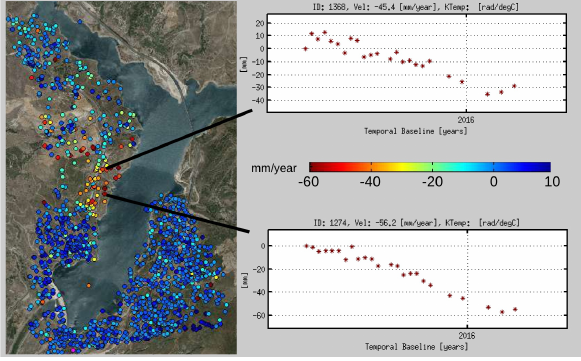
Figure 6. PS InSAR processing result of Rules reservoir area, Spain based on 24 S-1A images from 10/03/2015-